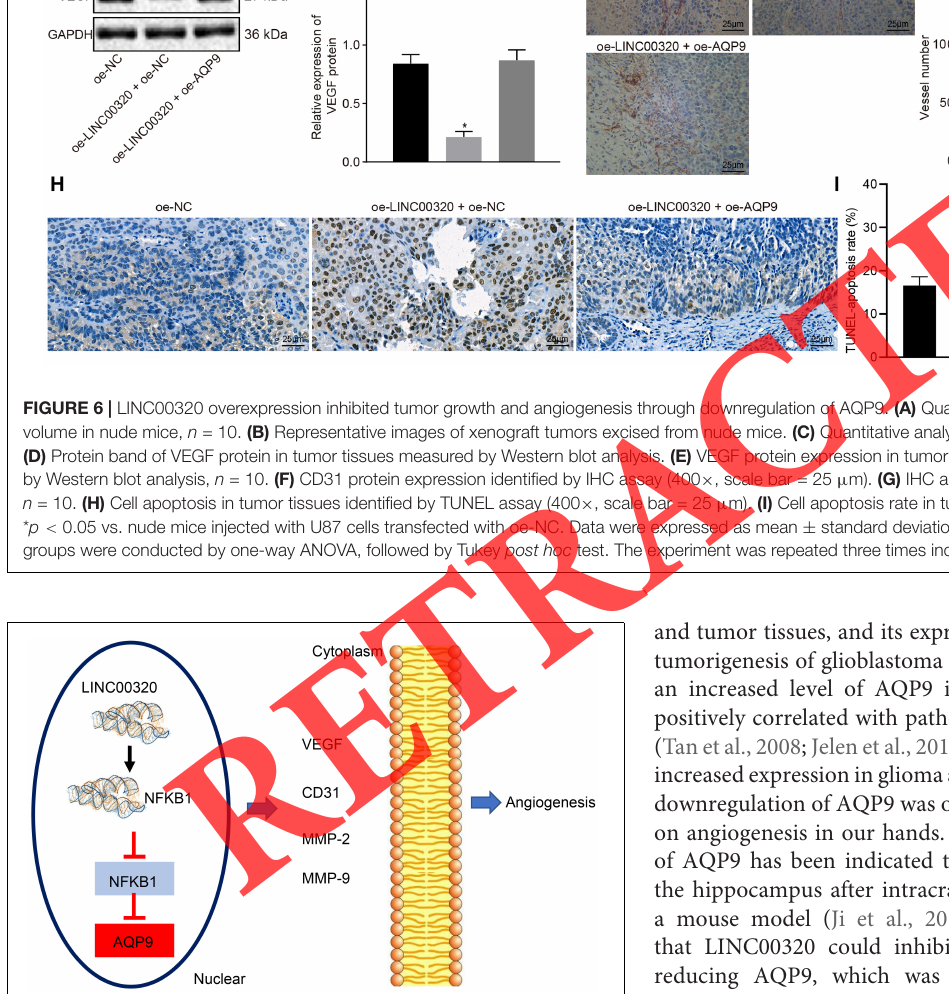
FIGURE 7 | LINC00320 downregulates AQP9 via inhibiting the recruitment of NFKB1 to the promoter region of AQP9, thereby preventing glioma